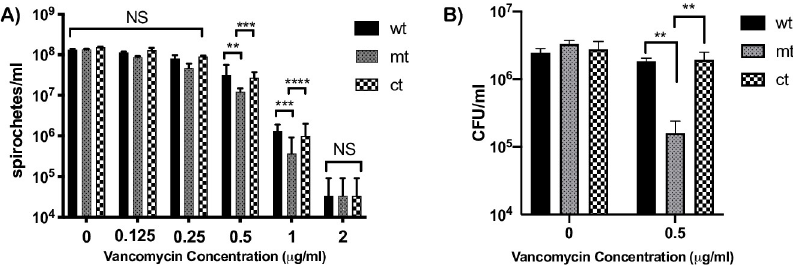
Fig 10. Sensitivity of bpiP mutant to vancomycin. All three strains (wt, mt and ct) were propagated at 10 6 /ml in BSKII growth medium with (A) 0, 0.125, 0.25, 0.5, 1 and 2 μ g/ml of Vancomycin, and grown at pH7.6/32˚C with 1% CO 2 . (A) Spirochetes were enumerated every 24 hrs by dark-field microscopy and the number of spirochetes/ml at day 5 post-treatment is shown. ( B ) Colony forming units of cultures with 0 or 0.5 μ g/ml of vancomycin at day 5 post- treatment were determined by diluting cultures of all three strains to 1:100,000 in 1X BSKII medium, plated on BSKII agar overlays and the final CFU/ml of the treated cultures were calculated after 10 days of incubation at 32˚C with 1% CO 2 . The CFUs were determined in triplicate, one of three independent experiment is shown. Statistically analysis was done using unpaired t -test. Statistical significance was accepted when p values were less than 0.05. The asterisks indicate the levels of significance as follows: ���� , p < 0.0001; ��� , p < 0.001; �� , p <